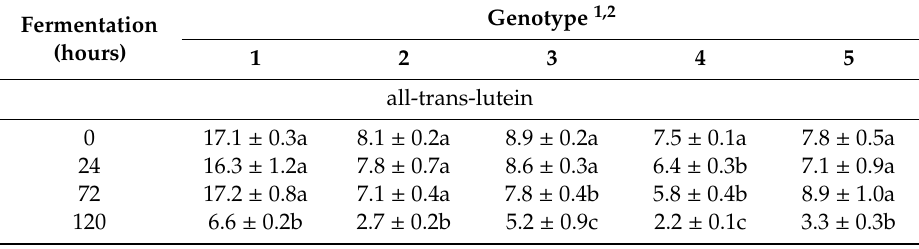
Table 2. Carotenoid concentration ( µ g / g dry weight (DW)) after traditional African fermentation “ogi”, after 0, 24, 72, and 120